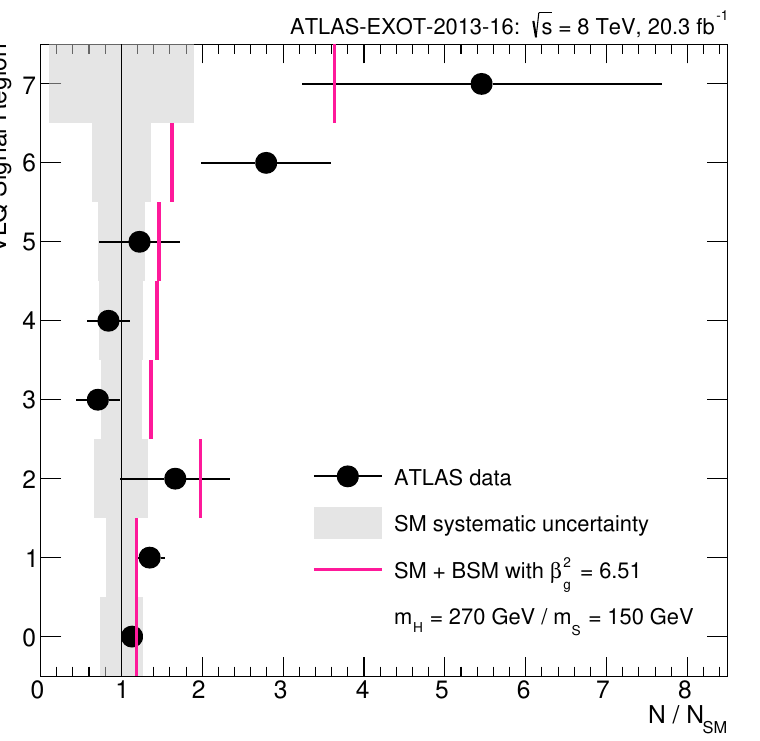
Figure 2 . The SM+BSM (cid:12)t result for the ATLAS Run 1 search for SS leptons in association with b -jets binned by the SRs de(cid:12)ned in the text. The horizontal axis represents a production rate normalised to that of the SM. The BSM prediction is scaled to the best-(cid:12)t value of (cid:12) 2 and its systematic uncertainty do not incorporate the constrains imposed by the (cid:12)tting